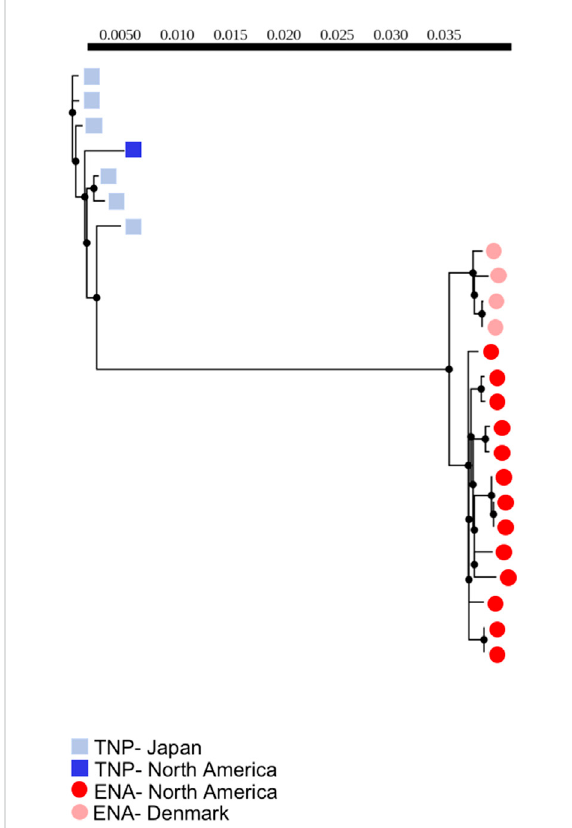
FIGURE 1 Maximum-likelihood phylogeny of threespine stickleback ( Gasterosteus aculeatus ) whole mitogenomes (excluding the control region) of individuals with no evidence of heteroplasmy. Branch lengths denote nucleotide divergence. Dark red circles indicate fi sh from North America with the Euro-North American (ENA) mitotype, light red circles indicate fi sh from Denmark with the ENA mitotype, dark blue squares indicate fi sh from North American with the Trans-North-Paci fi c (TNP) mitotype, light blue squares indicate fi sh from Japan with the TNP mitotype.Scalebarcorrelatestobranchlengthsandindicateslevel of